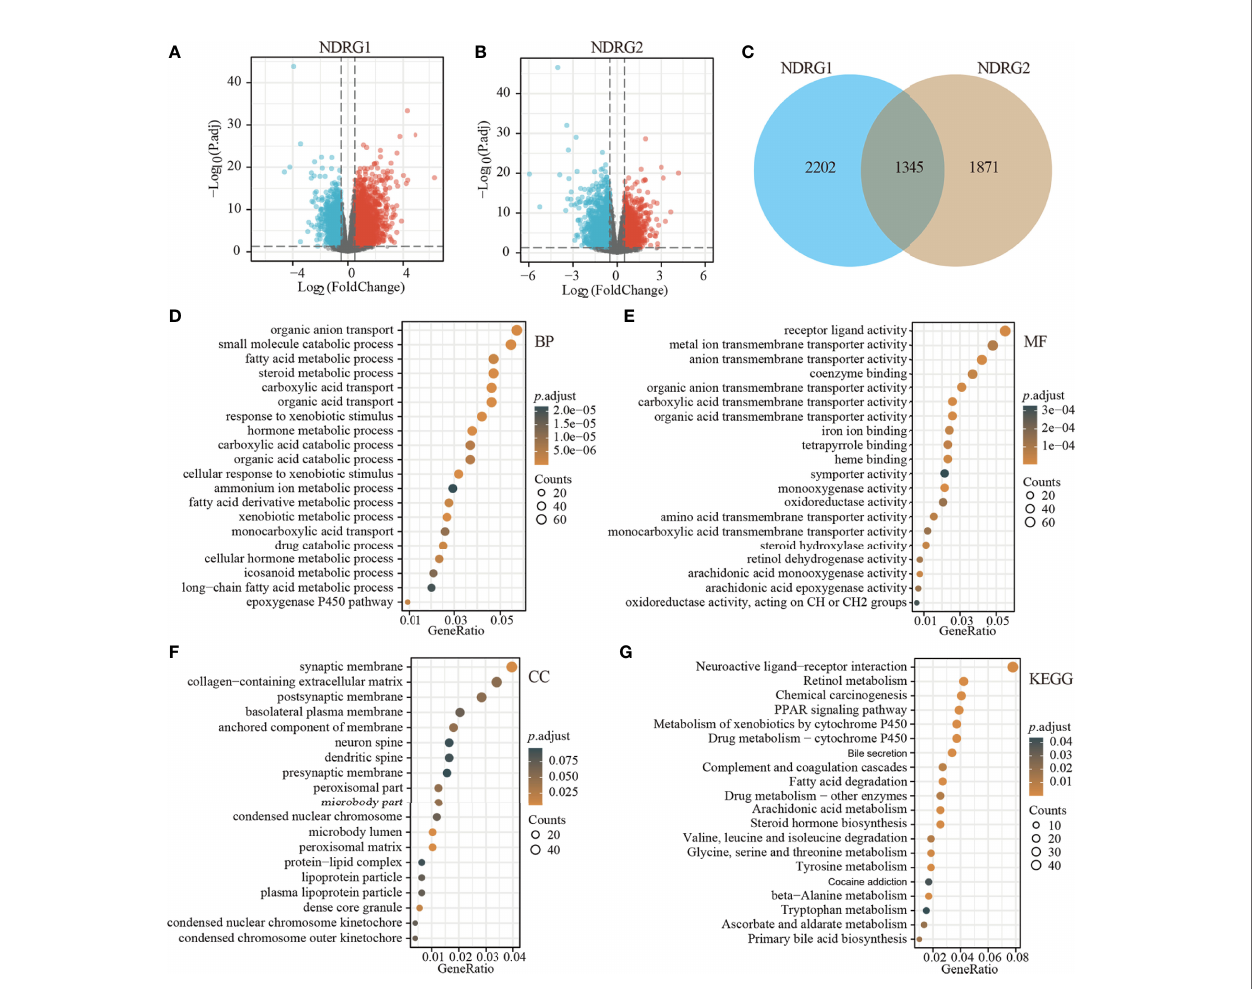
FIGURE 3 | Identi fi cation of DEGs in LIHC tissues with low- and high-expressed NDRG1 and NDRG2 groups. (A, B) Volcano plot of DEGs between low- and high- NDRG1 and NDRG2 expression groups based on the TCGA & GTEx datasets. (C) Venn diagram of the identi fi ed DEGs between low- and high- NDRG1 and NDRG2 expression groups. (D – G) The plots for the results of enriched GO terms and KEGG pathway analysis using the “ ClusterPro fi ler ” R package. The x-axis represents the proportion of DEGs, and different circle sizes represent the number of